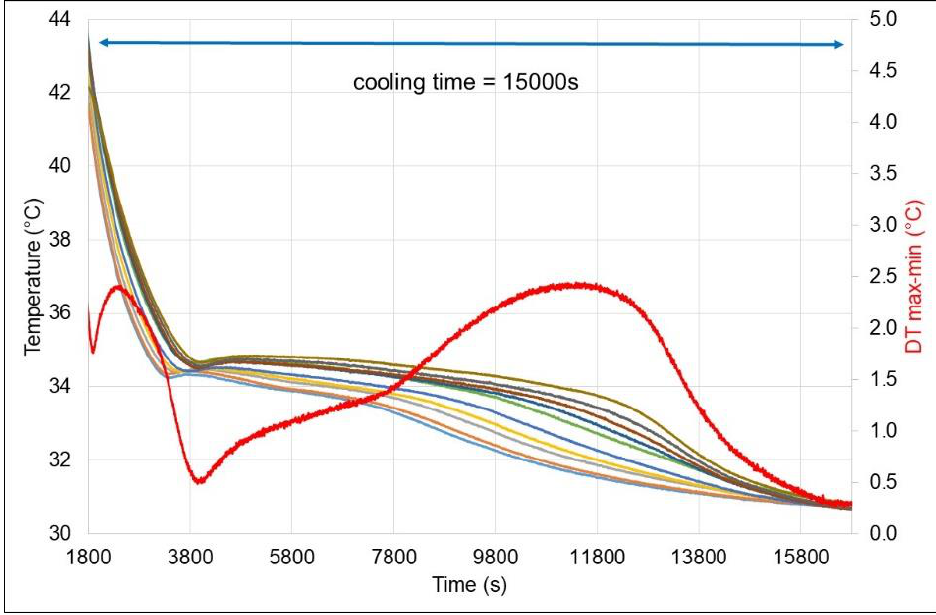
Figure 17. Measured surface temperature of the cells when the cooling airflow was characterized by a speed of 0.5 m/s. The heating elements were off over the time period indicated in the chart.